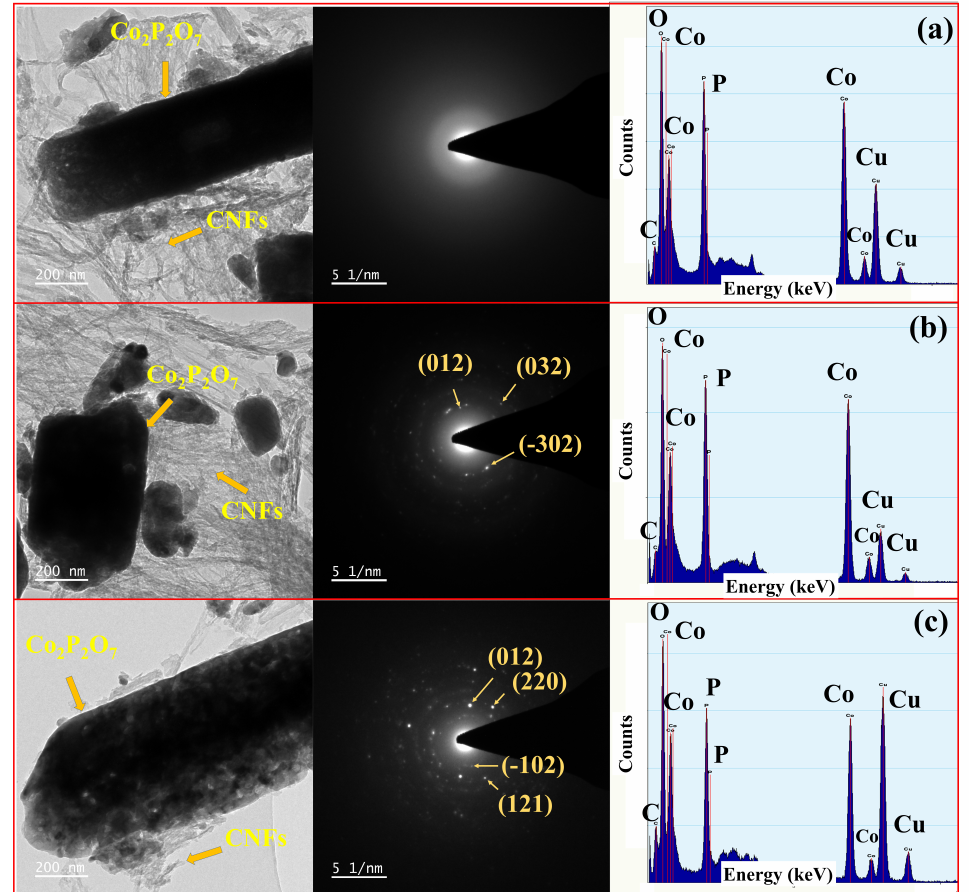
Figure 6. TEM bright field image, selected area electron diffraction (SAED) pattern and EDXs spectra